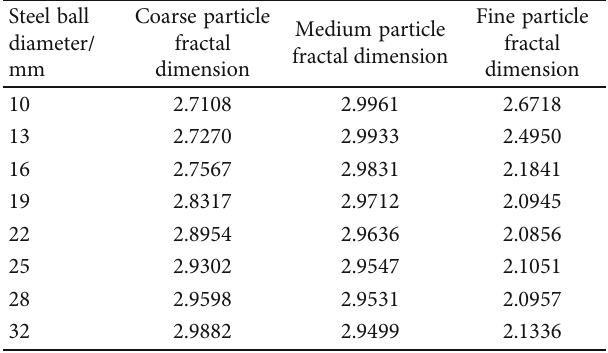
Table 2: The third-stage fractal dimension of magnetite particle size distribution by